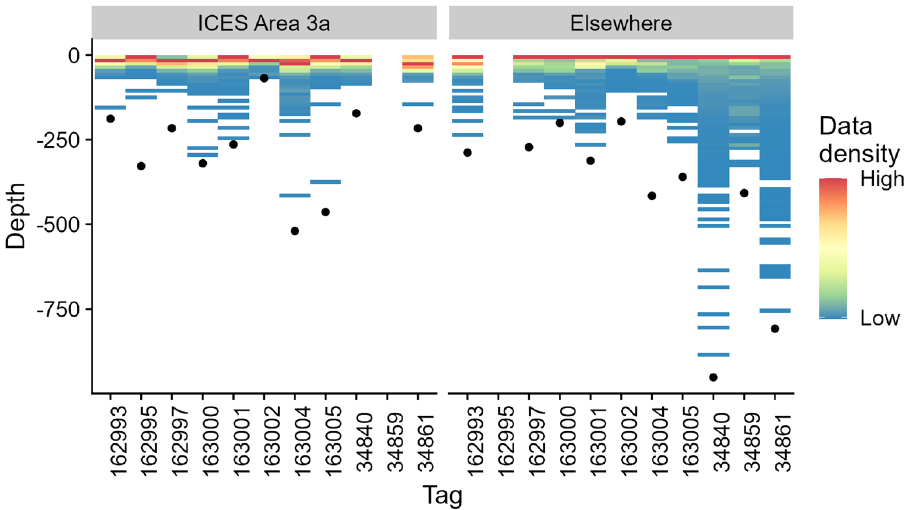
Figure 2. Distribution of registered depth while inside ICES Area 3a (Skagerrak, see Fig. 1, left) and for the three long tracks reaching into the Atlantic (right). Each column represents one fish, with the bar colour indicating the relative density of observed swimming depths. Black dots indicate maximum depth values registered by the